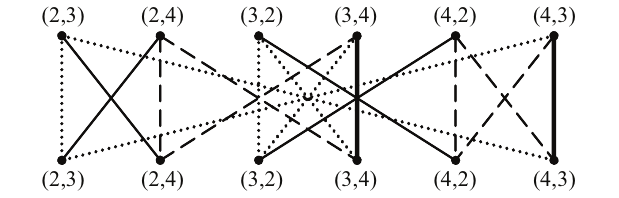
Figure 6. A bipartite graph that shows for the Birkhoff diamond (see Figure 3) the possible transitions from the input pair of colors ( a , b ) at the top of the graph to the output pair of colors ( c , d ) at the bottom of the